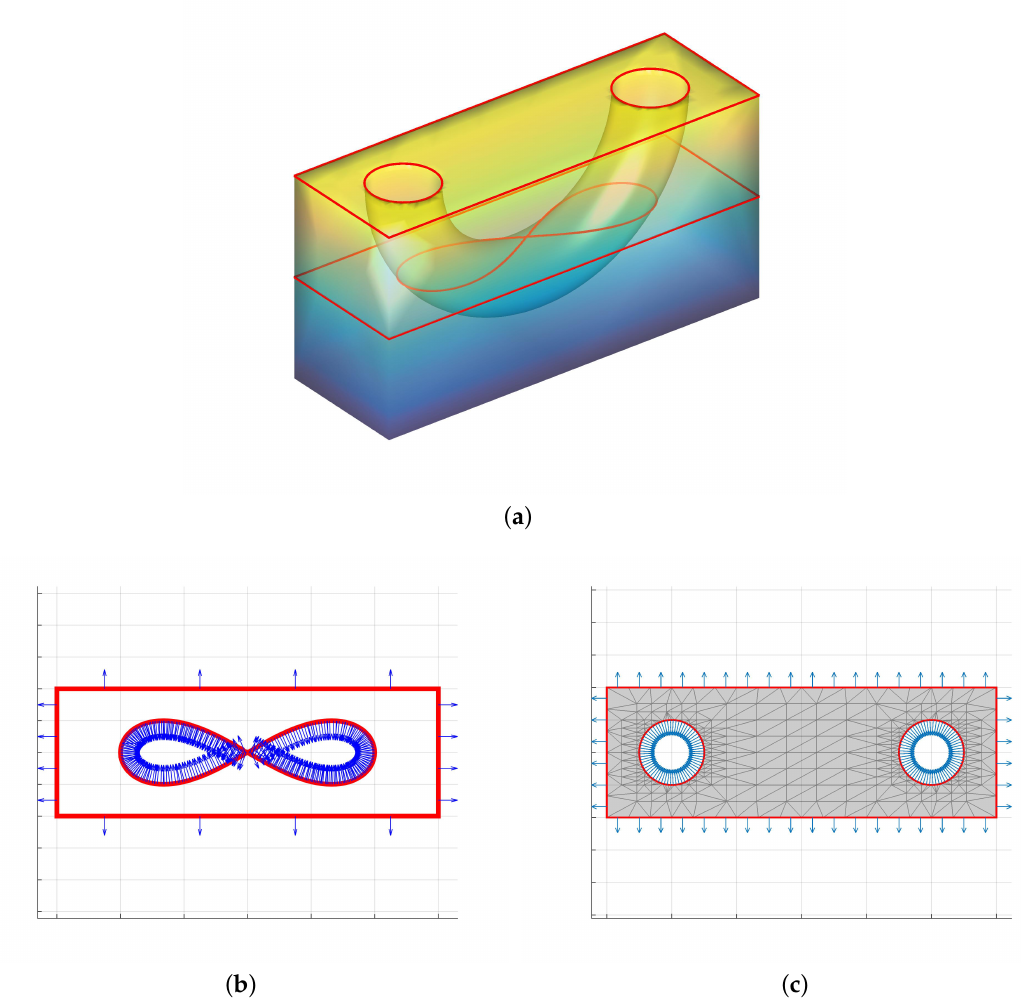
Figure 8. Internal Torus dataset. Our algorithm correctly handles contours, faces with holes, and internal saddle points. ( a ) Internal Torus dataset; ( b ) Oriented contour S O for an internal hole with a saddle point; ( c ) 2-manifold level set F with holes.